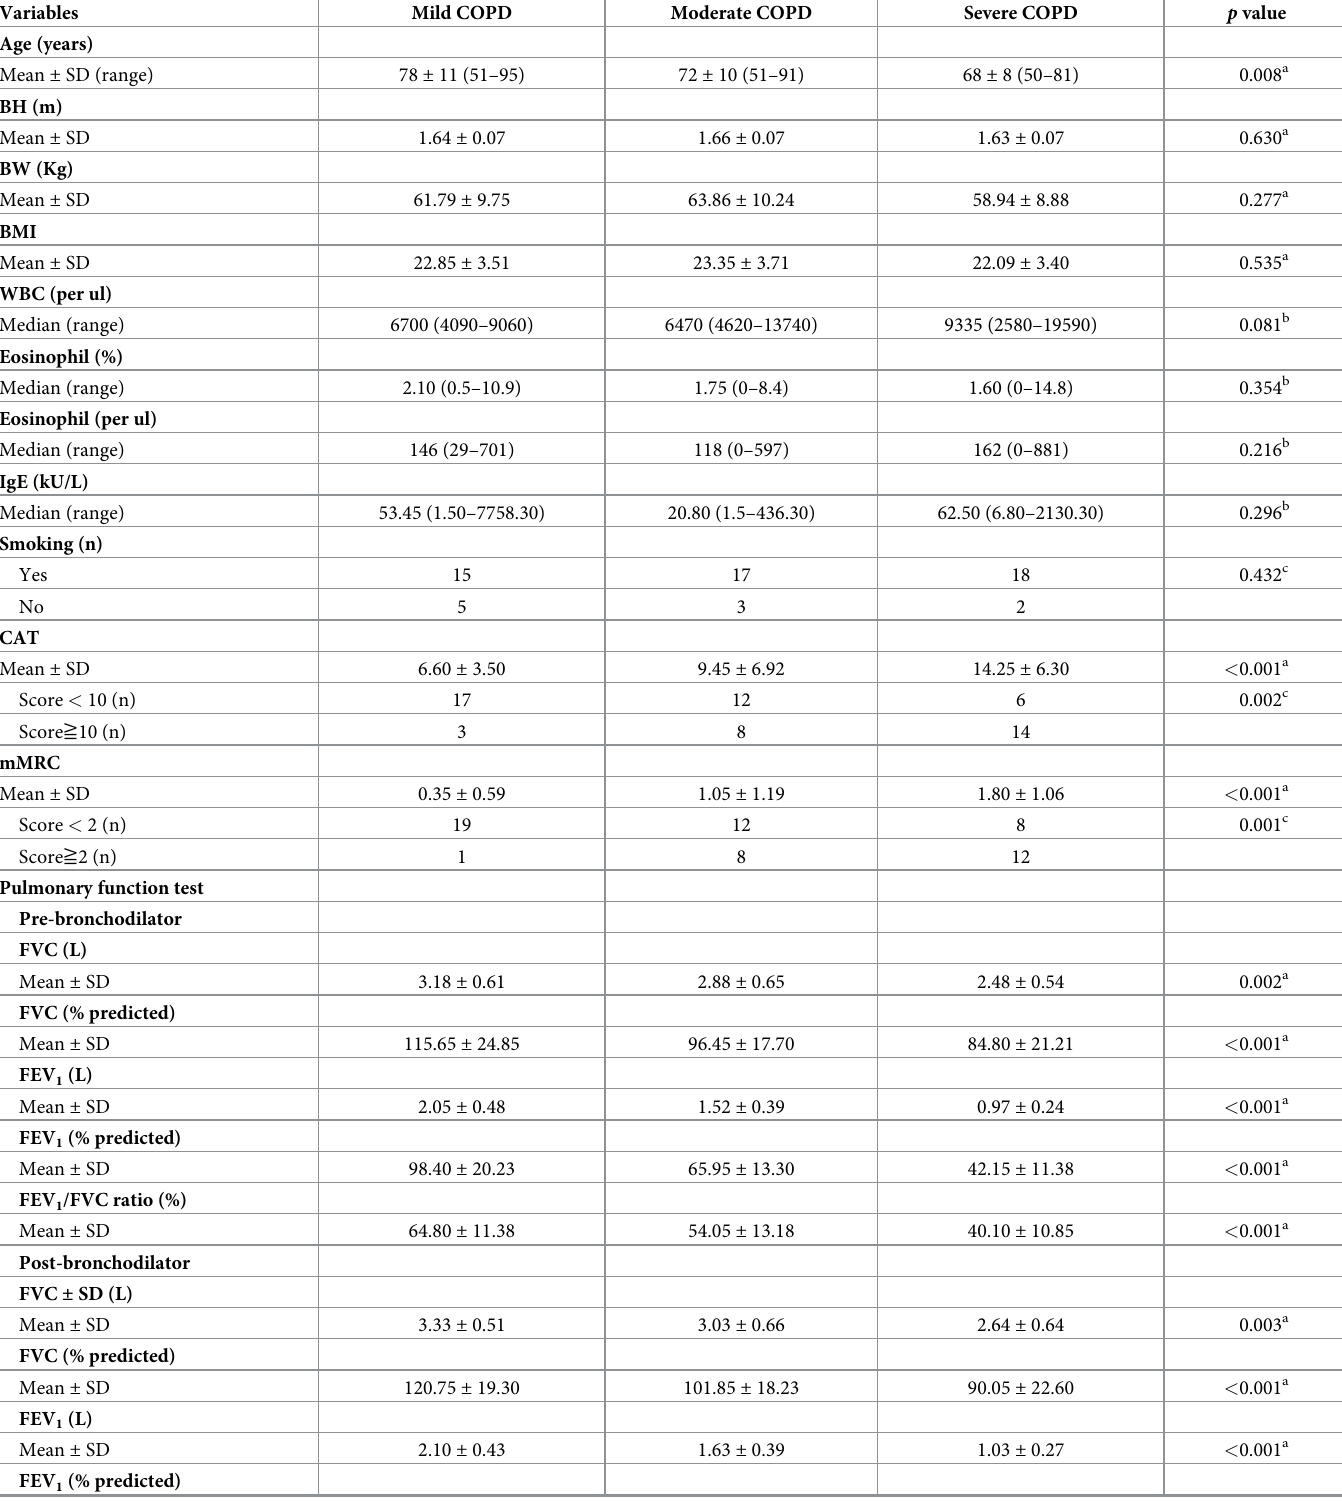
Table 1. The demographic and clinical characteristics of the study